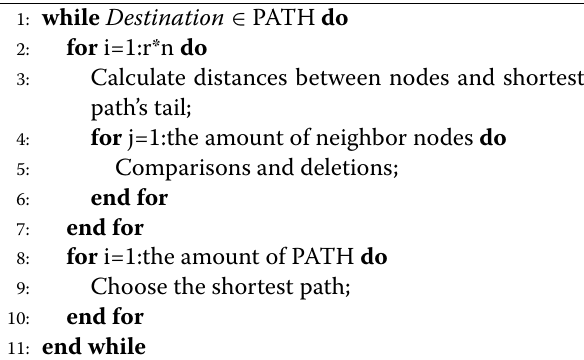
Algorithm 4 Simplified pathselection